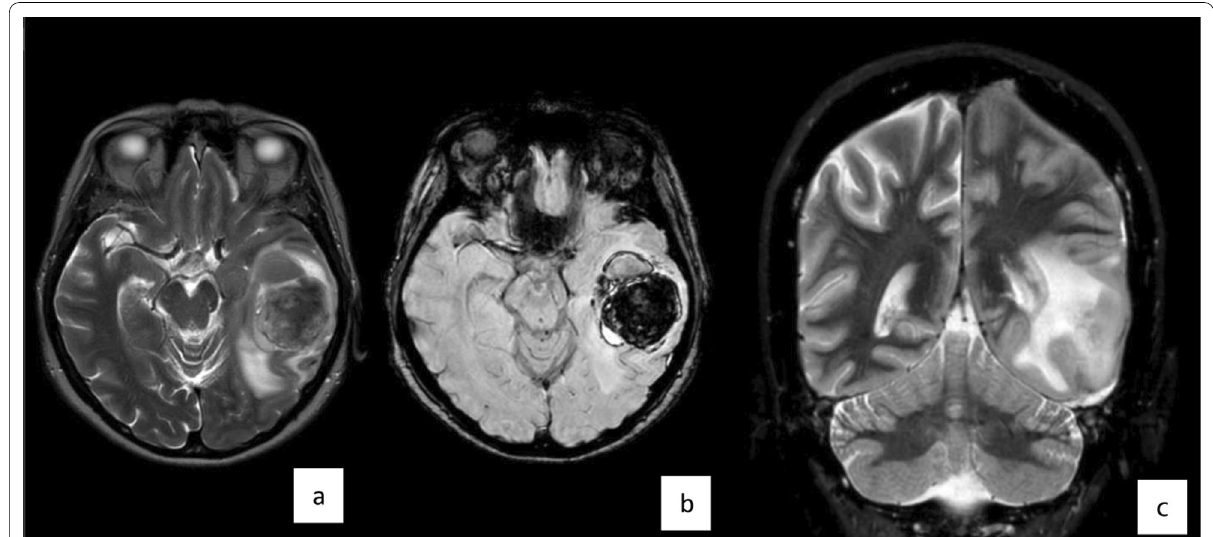
Fig. 1 The non-enhancing brain MRI: a axial T2 showed isointense of the left temporal lobe surrounded by hyperintense edema and medium structures dislocation; b axial SWI showed hypointense lesion in the left temporal lobe; c coronal T2 showed two subdural hematomas, left hemisphere